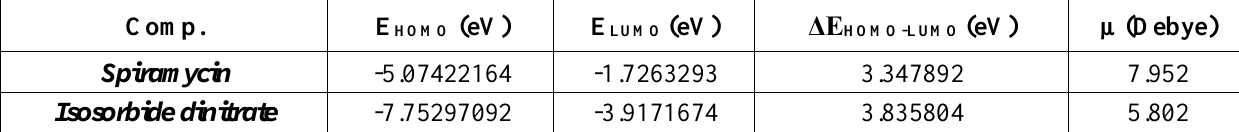
Table 3: DFT was used to calculate the physical parameters of the inhibitor molecule in a vacuum medium at ground state equilibrium geometries.